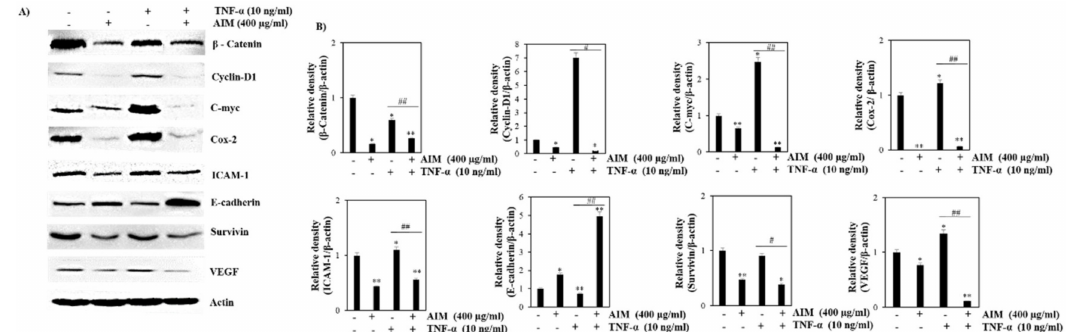
Figure 4. E ff ects of AIM and TNF- α induced AIM on NF- κ B-regulated proteins involved in proliferation, invasion, and angiogenesis. MCF-7 cells were seeded with the seeding density of 5 × 10 4 cells and pretreated AIM (400 µ g / ml) for 1 h, followed by the treatment of TNF- α (10 ng / mL) for 24 h. The control cells were left untreated. The whole cell protein lysate was prepared and 30 µ g of proteins were resolved in SDS-Polyacrylamide gels. ( A ) Western blot analysis of various NF- κ B related proteins involved in cancer cell proliferation, invasion, and angiogenesis, ( B ) Densitometry analysis of the data in western blot analysis by ImageJ software. The values were normalized against β -actin. * p < 0.05, ** p < 0.01 vs. the control group, # p < 0.05, ## p < 0.01 vs. the TNF- α treated